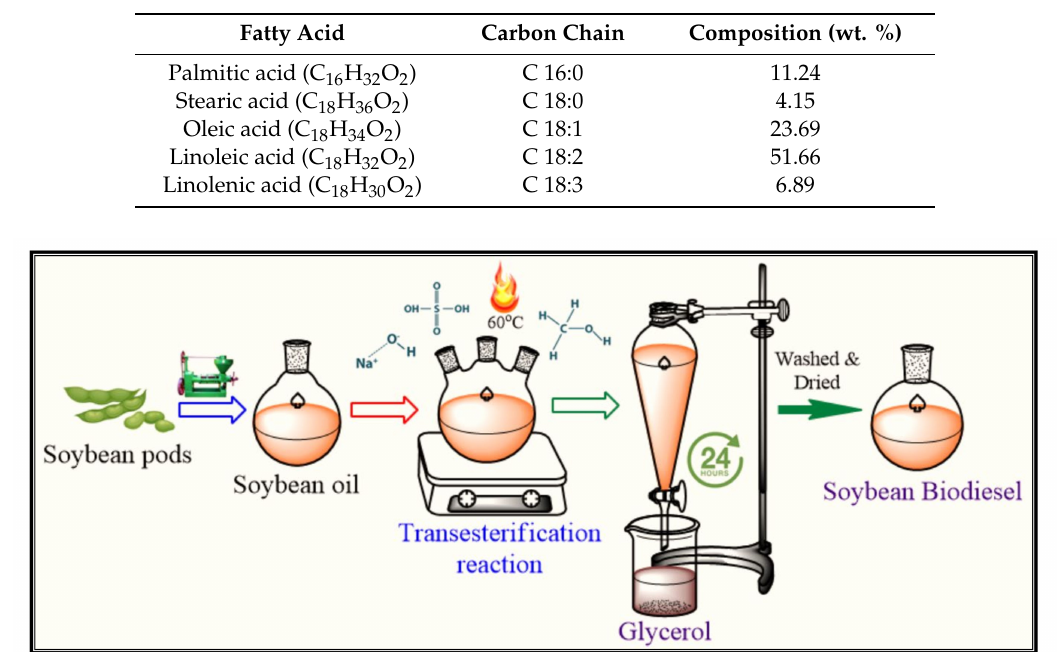
Figure 1. Production of soybean biodiesel using transesterification